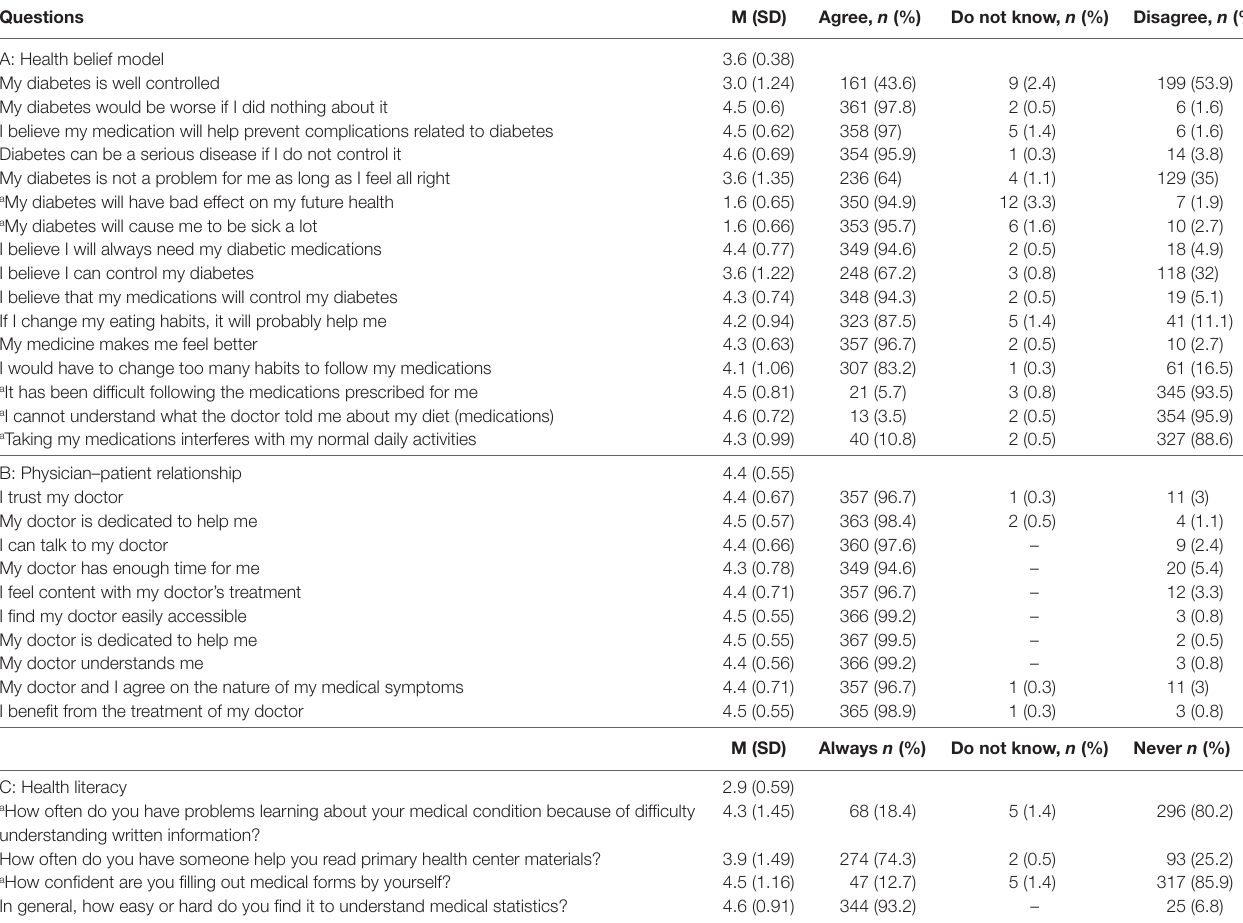
Table 1 | Mean (sD), percentage of agree, do not know, and disagree of questionnaire items.